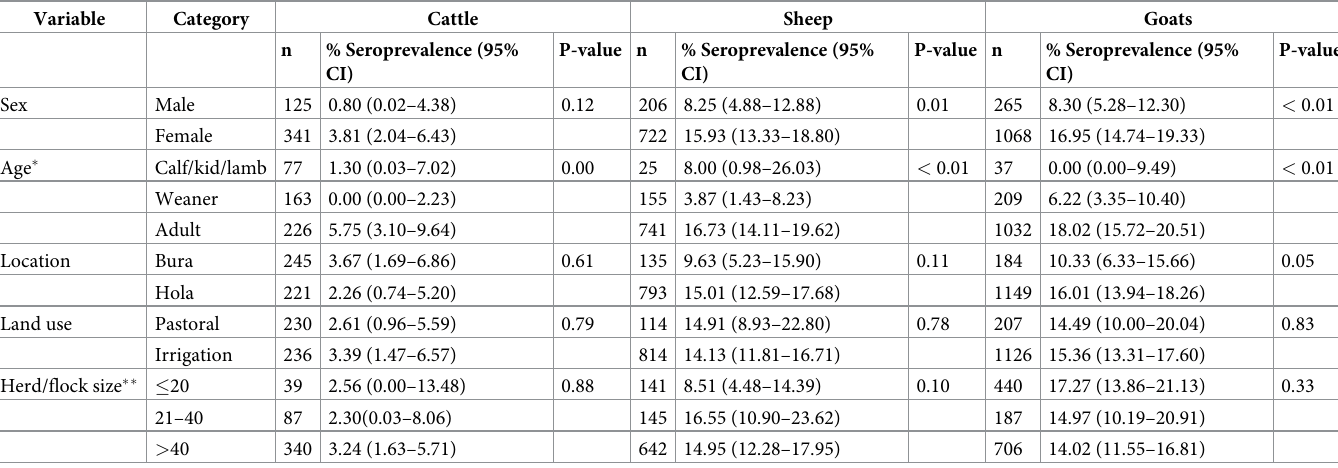
Table 2. Distribution of the seroprevalence of C . burnetii by livestock species.